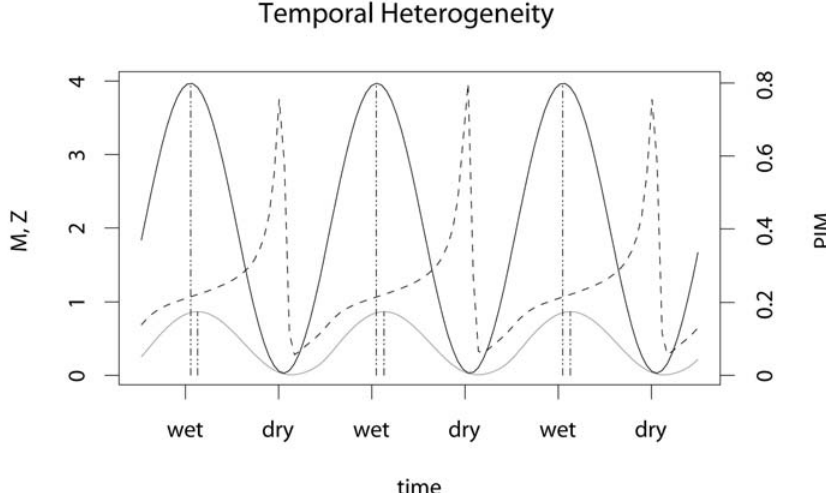
Figure 1. Dynamics with Temporal Heter- ogeneity The components of EIR follow different trends when mosquito populations vary temporally. Mosquito density (solid black) forms the dominant component of HBR. The density of infected mosqui- toes (solid gray) peaks shortly after the density of mosquitoes (dotted vertical lines align the peaks). In contrast, the proportion of infectious mosquitoes (dashed) peaks while the mosquito pop- ulation is declining. Seasonal mosquito emergence was modeled to have an long- termaverage M = H ’ 2( K =2and H =1). The ticks on the x-axis mark the peaks of the wet and dry seasons. DOI: